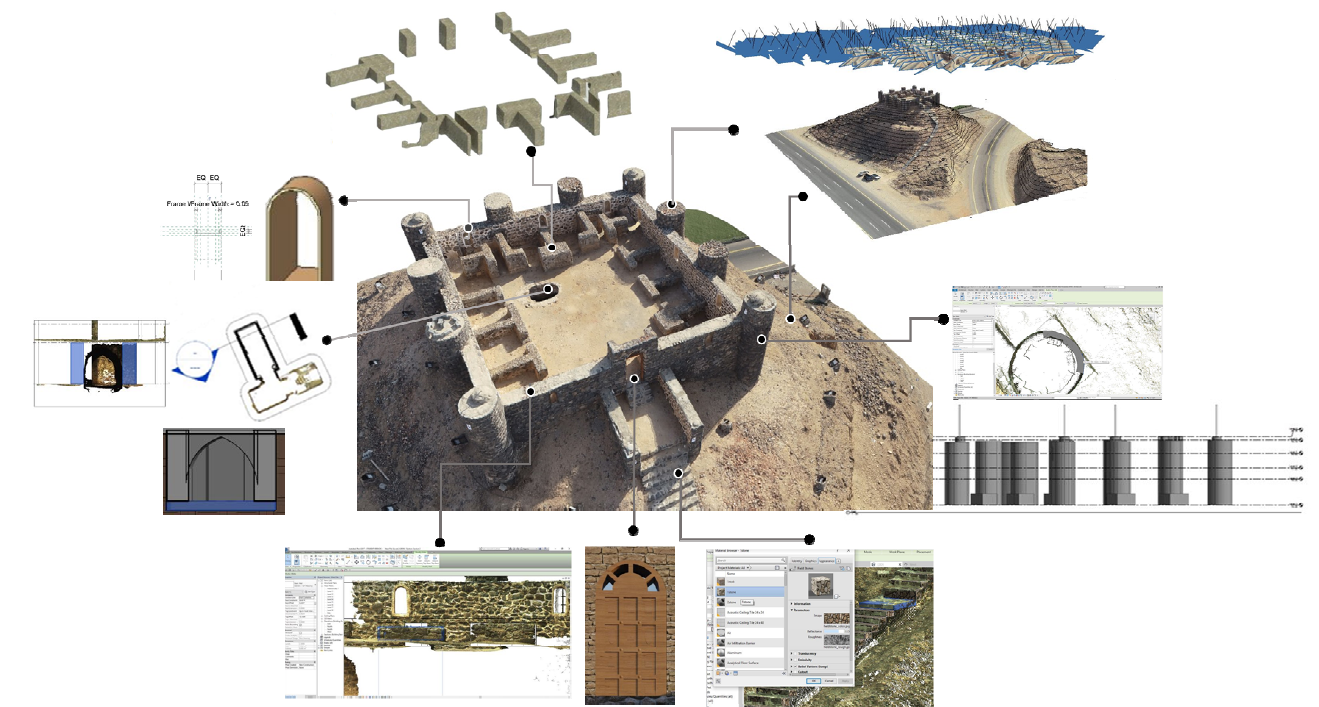
Figure 22. From enhanced point clouds to a HBIM model—the Asfan